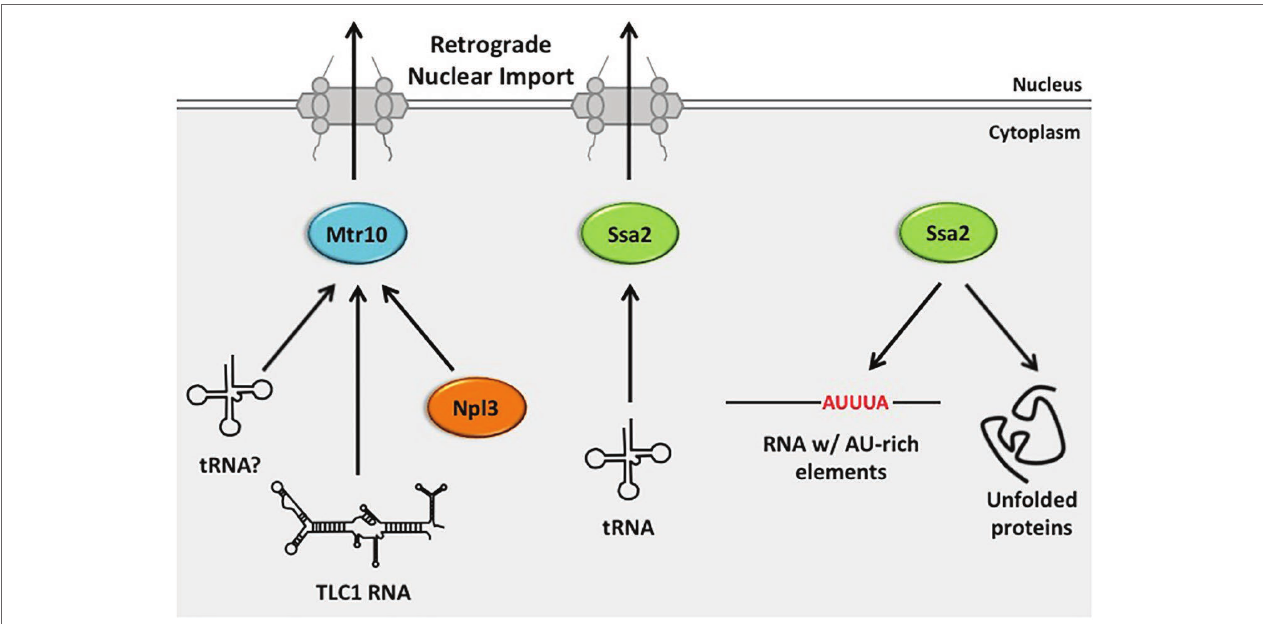
FIGURE 6 | The role of budding yeast retrograde tRNA nuclear importers in nuclear import and gene expression regulation of other RNA and proteins. Retrograde tRNA nuclear import is mediated in a Ran-GTP-dependent manner, likely by Mtr10 and a Ran-GTP-independent manner by Ssa2. Mtr10 is also an importer of nuclear export protein Npl3 and it is implicated as a nuclear importer for the TLC1 RNA of telomerase. Ssa2 has additional non-import related functions, including its well-characterized role in protein folding. Members of the Hsp70 family also bind RNAs containing AU-rich elements, leading to their